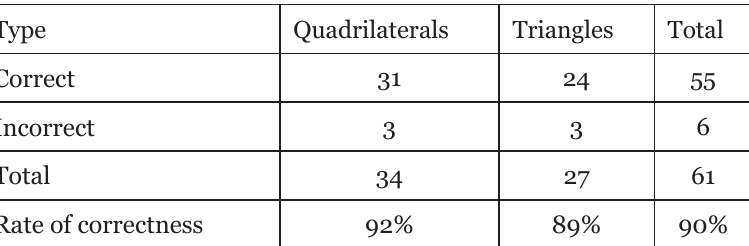
Empirical Results of